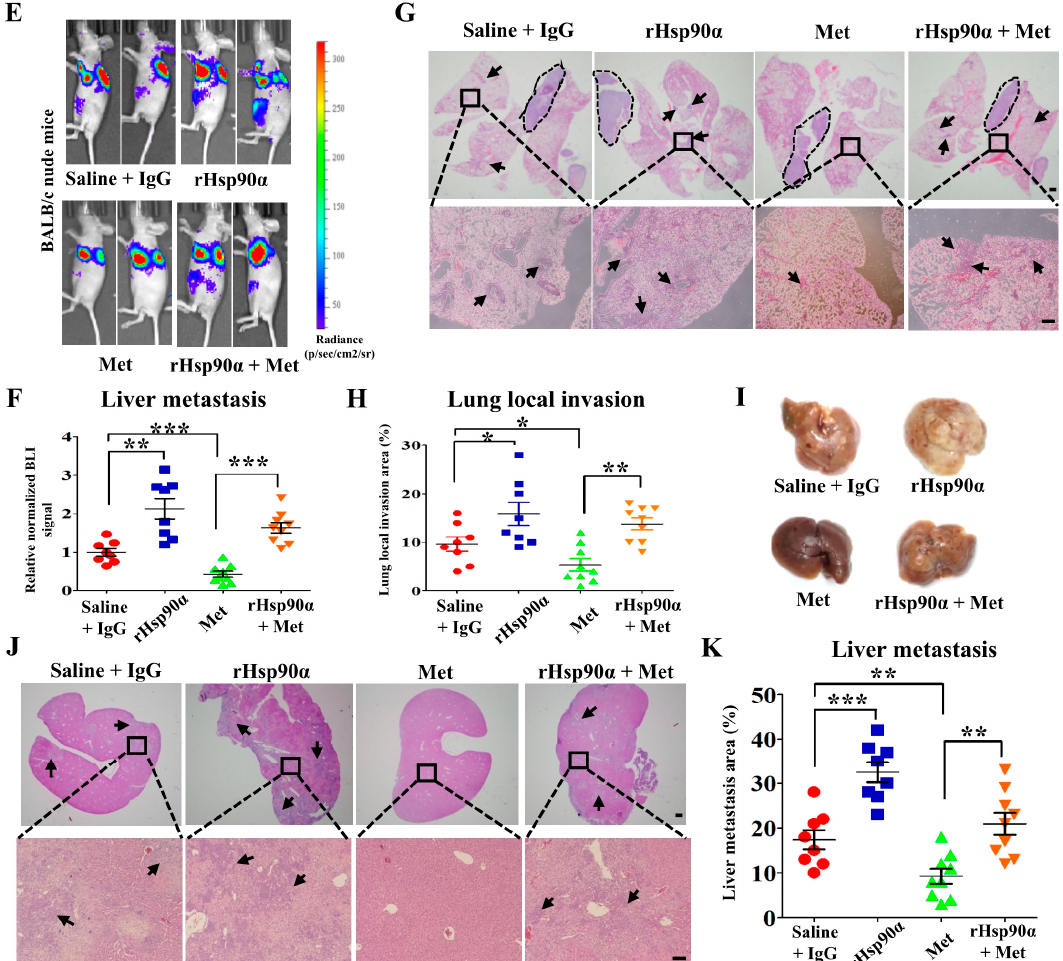
Figure 2. Recombinant Hsp90 α reversed the inhibitory e ff ects of metformin on tumor metastasis. Representative images of cell migration ( A ) and invasion ( B ) in H1299 cells treated with or without metformin (200 µ M) and recombinant Hsp90 α (10 ng / mL). Quantified results of cell migration ( C ) and invasion ( D ) in H1299 cells treated with or without metformin and recombinant Hsp90 α . Scale bar, 100 µ m. ** p < 0.01, *** p < 0.001. ( E – K ) H1299 cells with luciferase activity were orthotopically injected into nude mice ( n = 8 or 9 / group). Mice were treated with or without metformin (200 µ M) and recombinant Hsp90 α (10 mg / kg). ( E ) Representative bioluminescent images (BLI) and ( F ) quantified results of fluorescence intensity for liver metastasis. ( G ) Representative H&E images of lung local invasion, andtheareainthecircleistheprimarytumor.( H )Quantifiedresultsoflunglocalinvasionareas. Scale bar, 2 mm (above), 200 µ m (below). ( I ) Representative images of liver tissue. ( J ) Representative H&E images for liver metastasis. Scale bar, 2 mm (above), 200 µ m (below). ( K ) Quantified results of liver metastasis